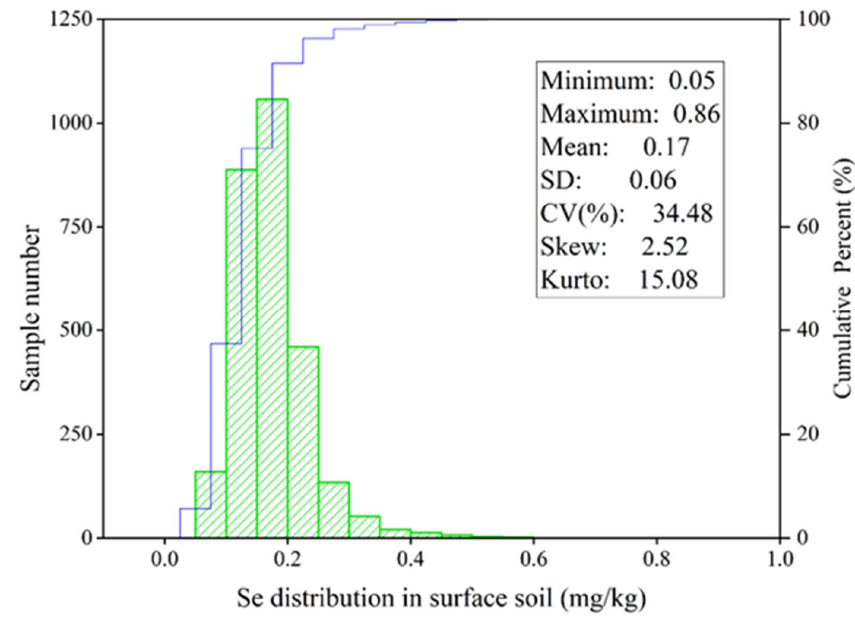
Figure 2. Basic statistics and sample distribution of soil Se content in Kaizhou. Table 2. The basic statistics of environmental factors.